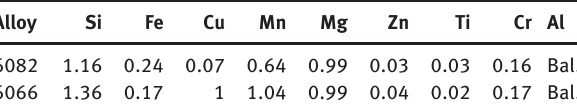
Table 1: Compositional analysis (in weight percent) of the experimental materials.